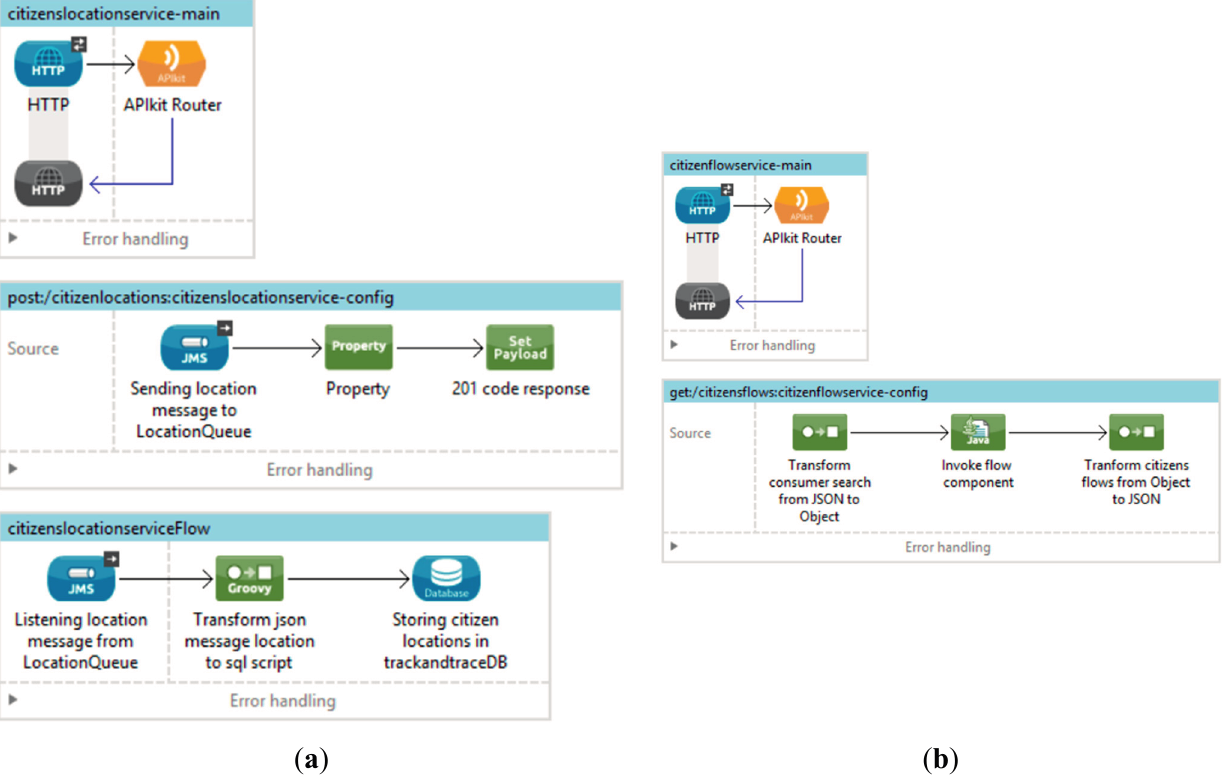
Figure 13. Mule flow. ( a ) Location message acquisition service; ( b ) Citizens flows generation